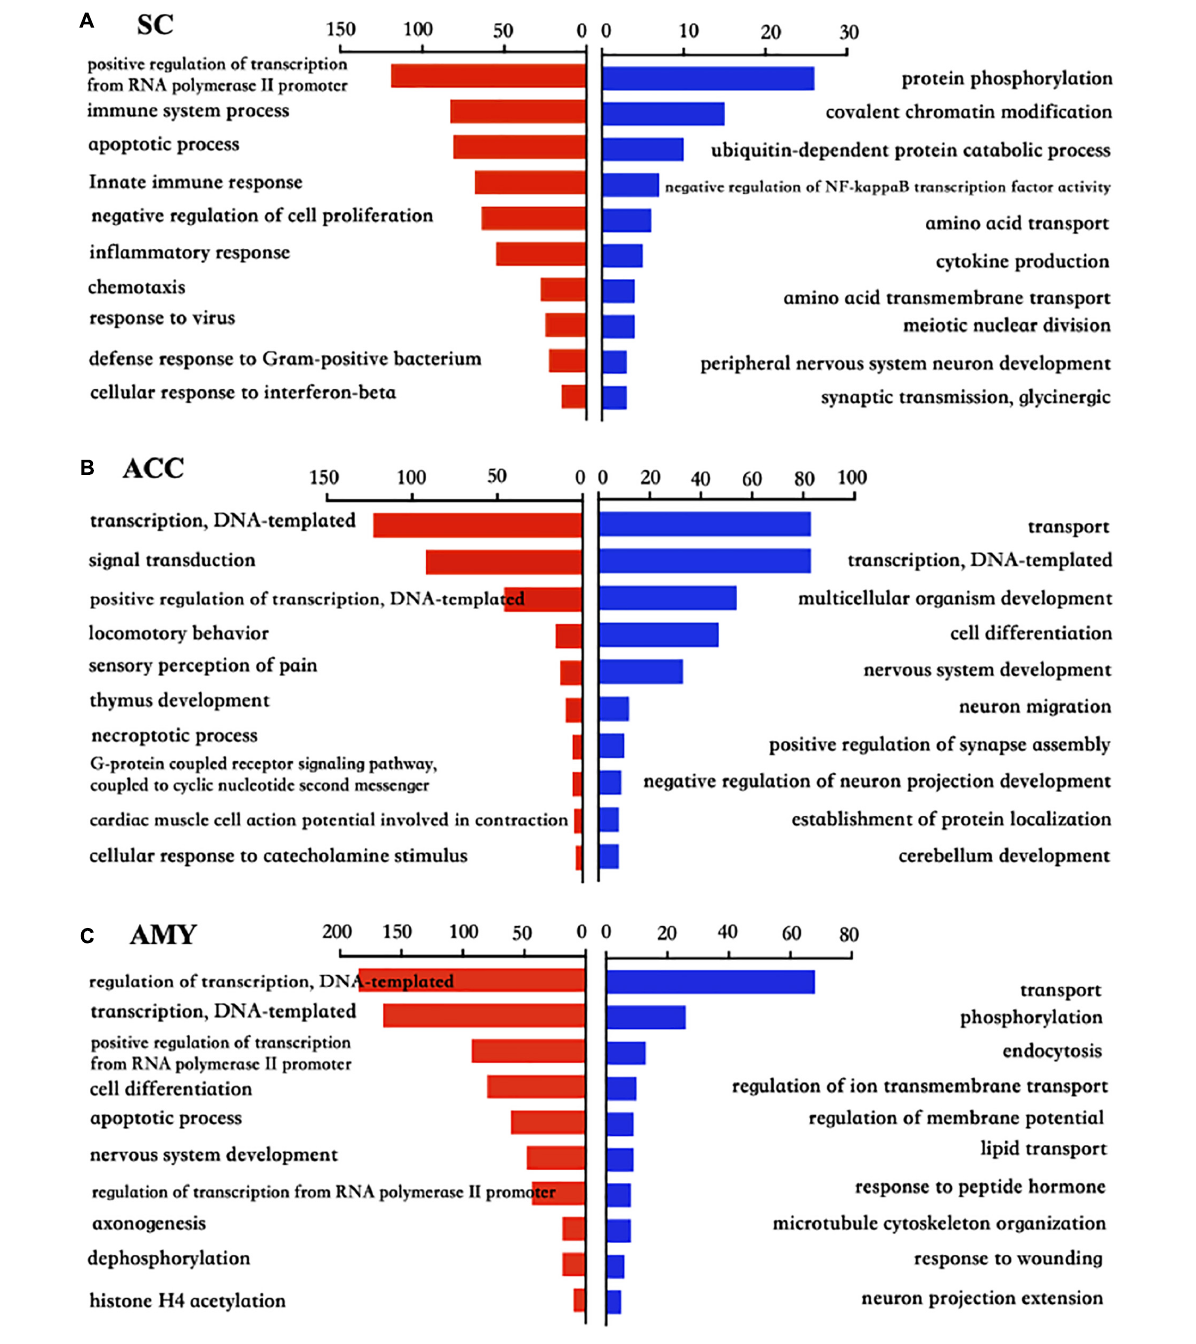
panels on the left) and axon guidance, hippo signaling pathway, and T cell receptor signaling pathway for the downregulated genes (blue panels on the right) ( Figure 6A ). In the ACC, the obvious enrichments were seen in the cAMP signaling